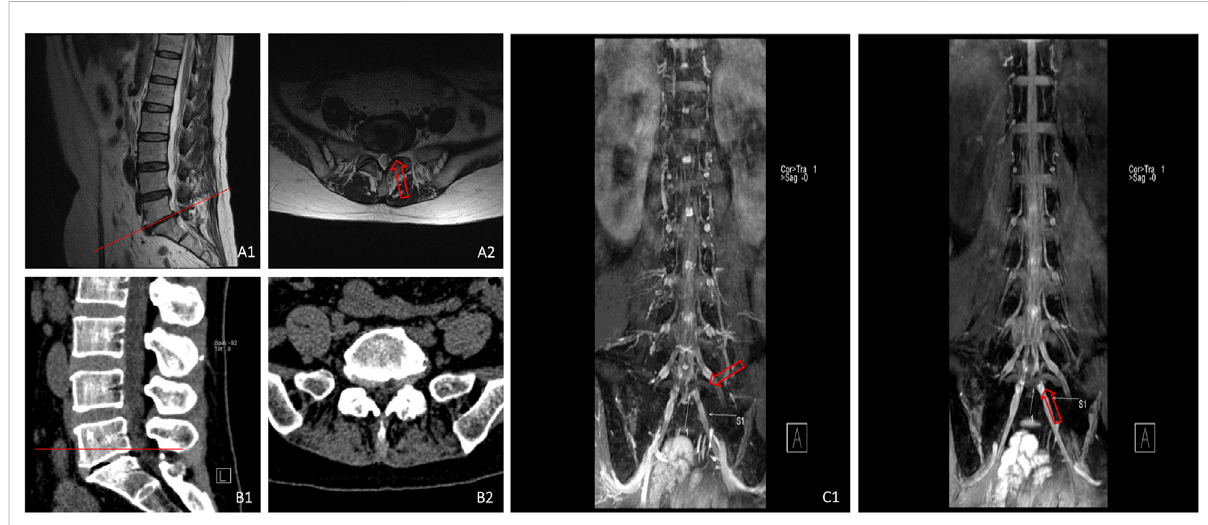
FIGURE 7 MRI (A1,A2) showed that the nucleus pulposus on the left side of L5/S1 segment was compressed, CT (B1,B2) illustrated that there was no substantialcompressionontheleftsideofL5/S1segment,and3D-DESS (C1,C2) revealedthatthecontinuityofleftS1nerverootwasinterruptedwith notable local